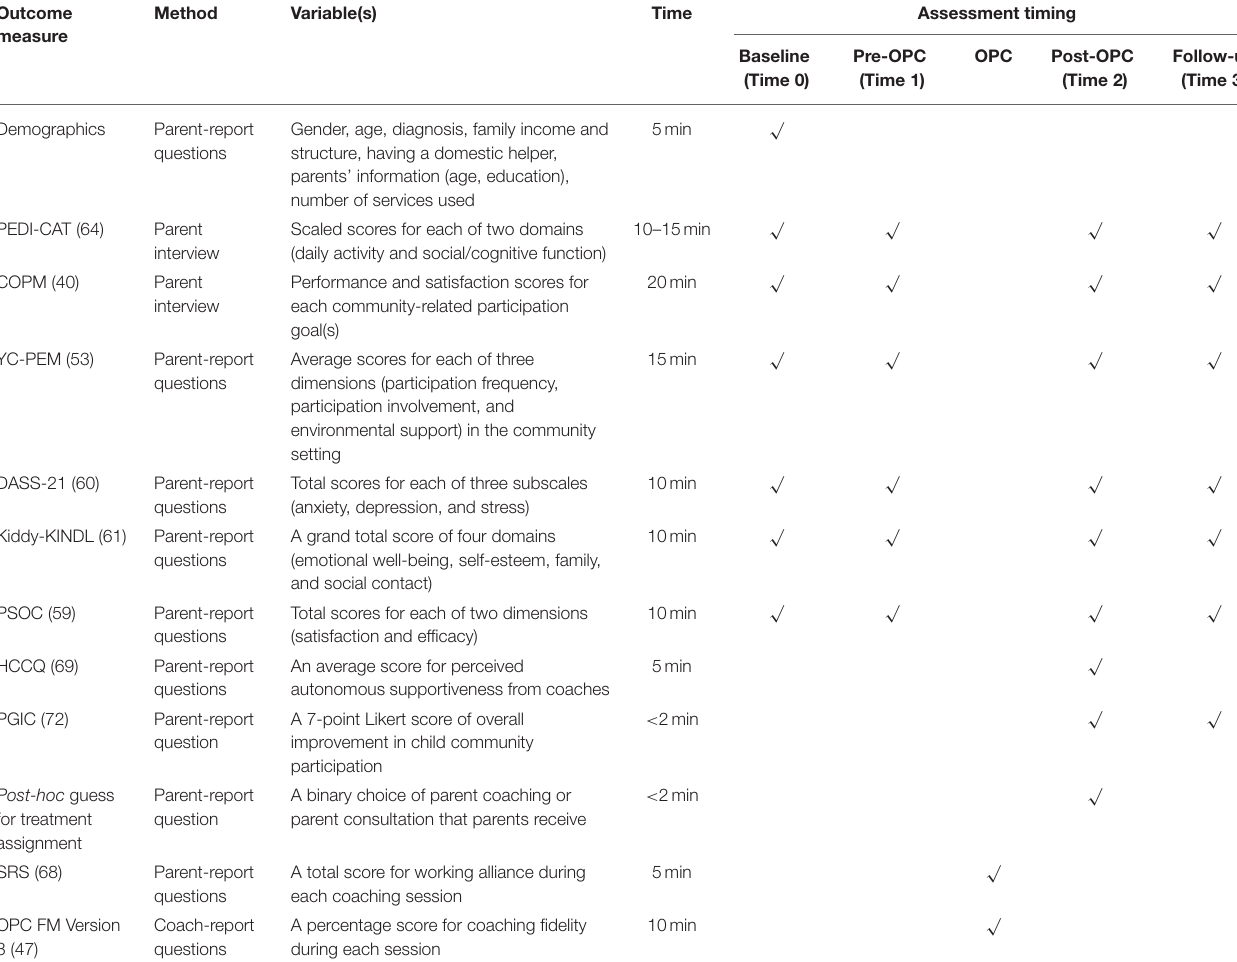
TABLE 1 | Outcome measures used and timing in the